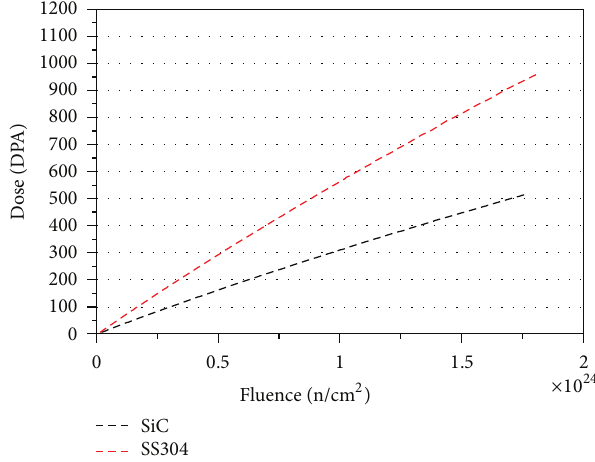
Figure 4: DPA dose for stainless steel and SiC f /SiC.